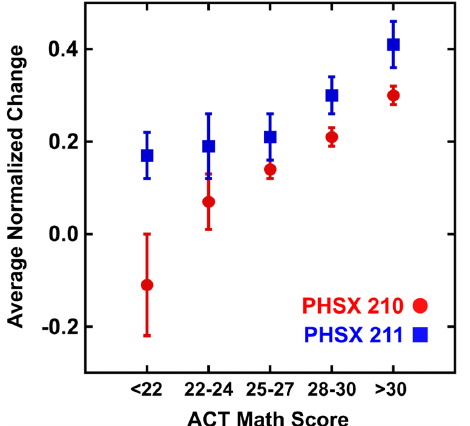
FIG. 2. The average normalized change for pretest and post-test FCI scores for students who completed PHSX 210 (red circles) or PHSX 211 (blue squares) sorted by ACT math scores. The uncertainty corresponds to the 68% confidence interval of the standard